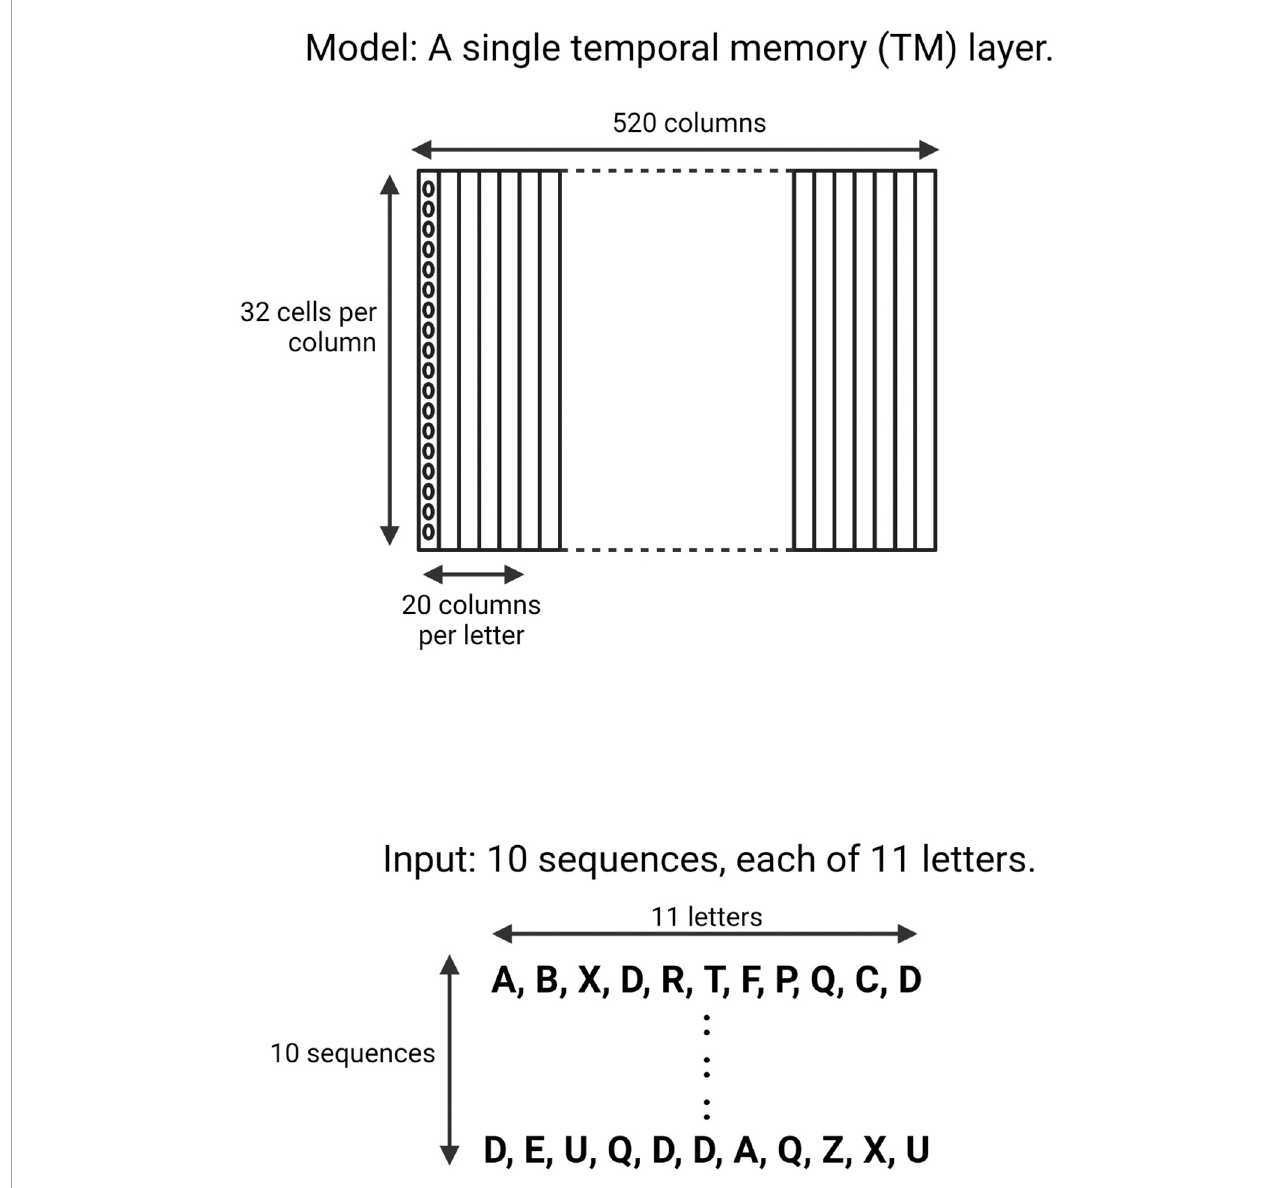
FIGURE1 Schematic of the neocortical layer temporal memory (TM) model and the input it learned. The network consisted of 520 columns, with 32 cells per column. Each upper-case letter has a receptive field of 20 columns. The input consists of 10 sequences, each of 11 upper-case letters selected randomly from a uniform distribution with